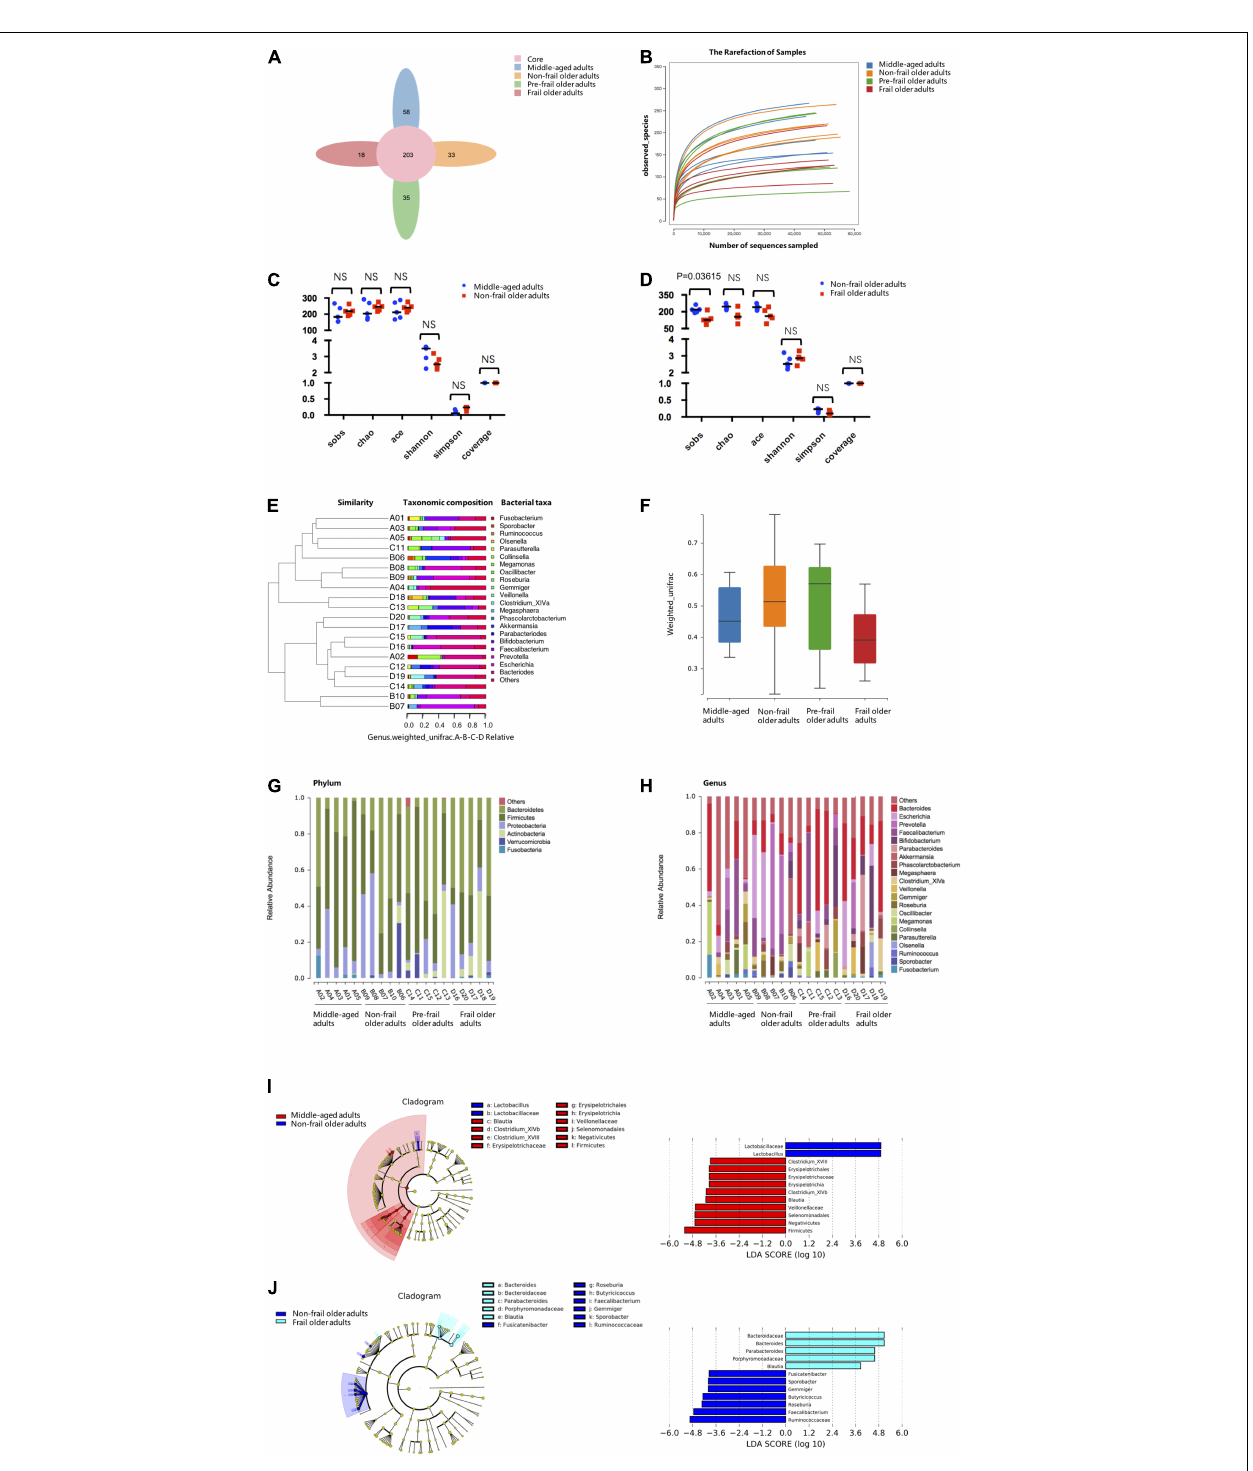
Frontiers in Medicine |